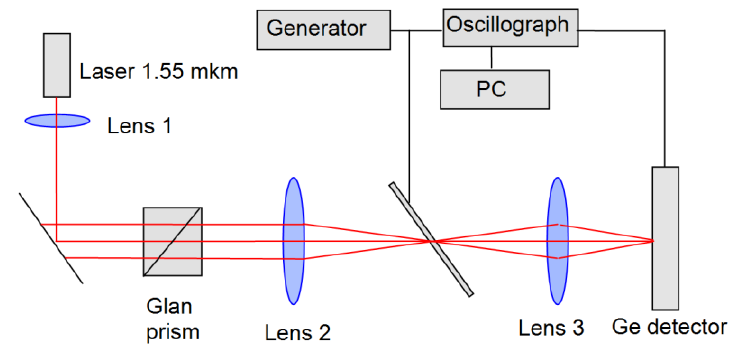
Fig.1 . The transmission setup for measuring the electro optic effect in the HES.